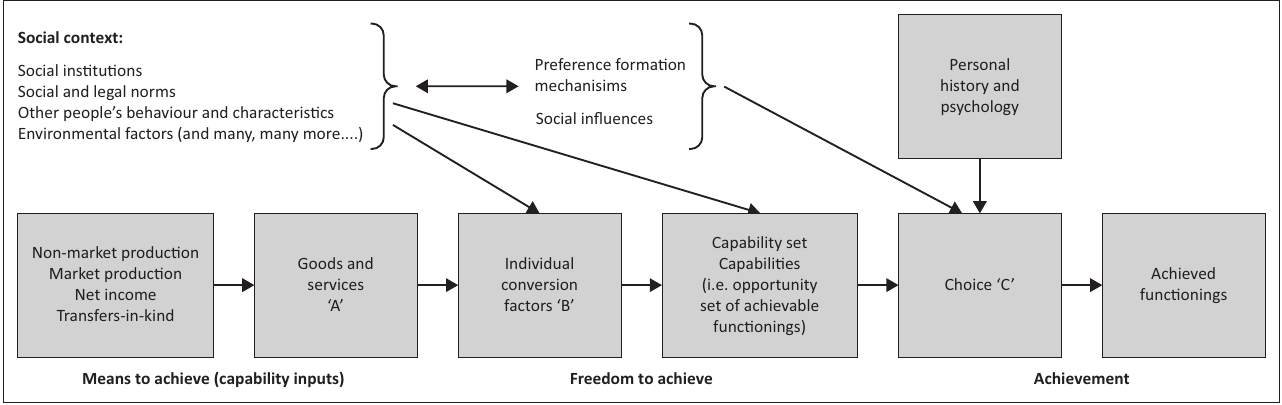
Freedom to achieveMeans to achieve (capability inputs) Achievement